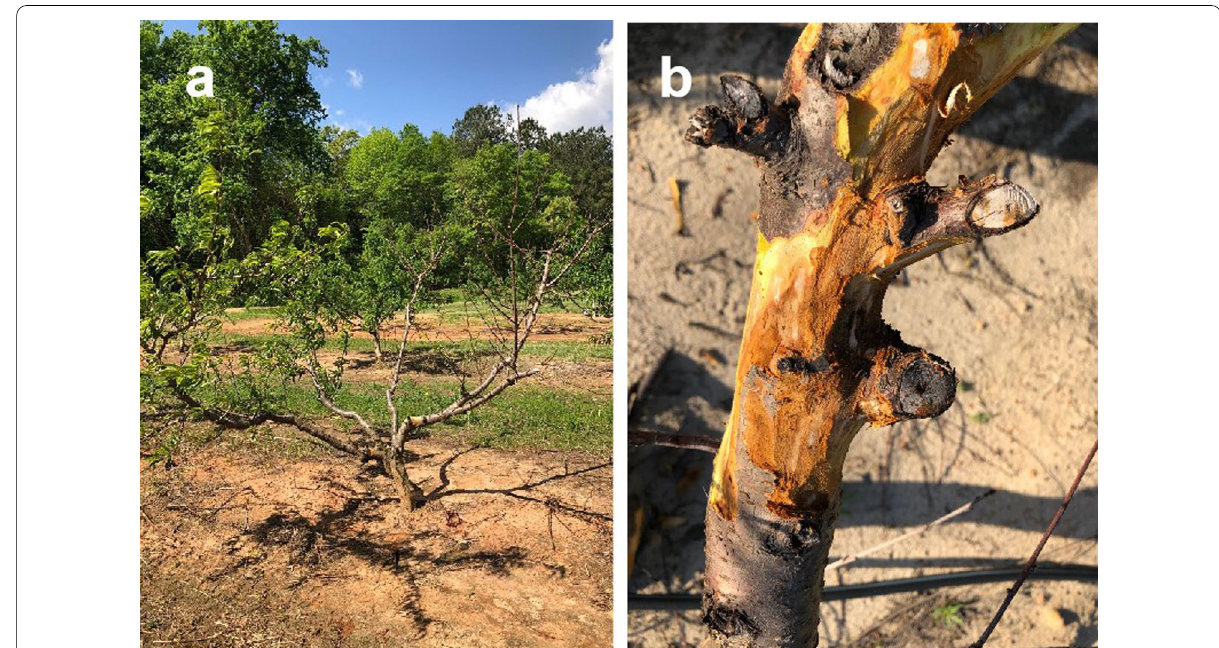
Fig. 4 Symptoms of bacterial canker. a Scaffold limb collapse in early spring (South Carolina, 2018). b Cankers generated by infection through pruning wounds with a clear line between necrotic bark tissue and non‑symptomatic bark tissue (South Carolina,